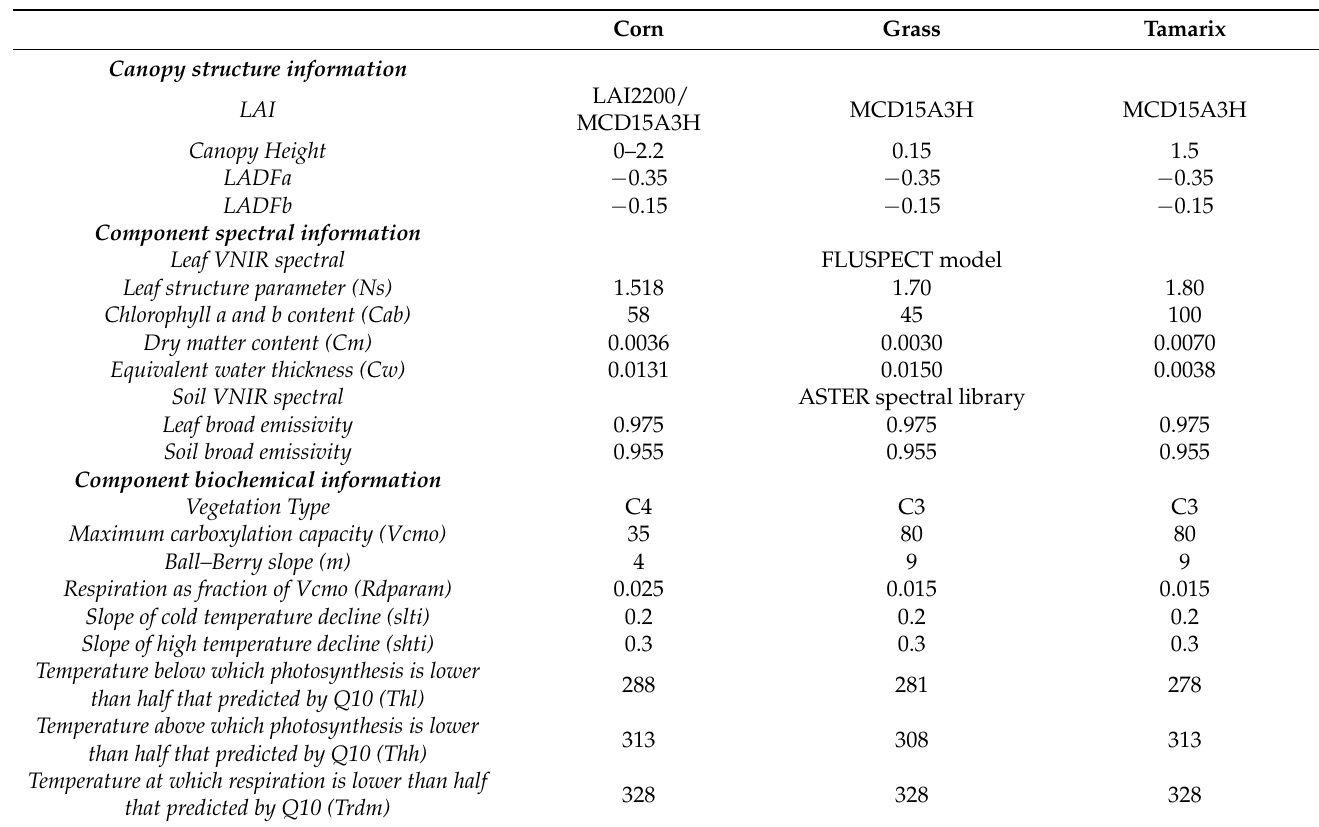
Table 2. Inputs of SCOPE